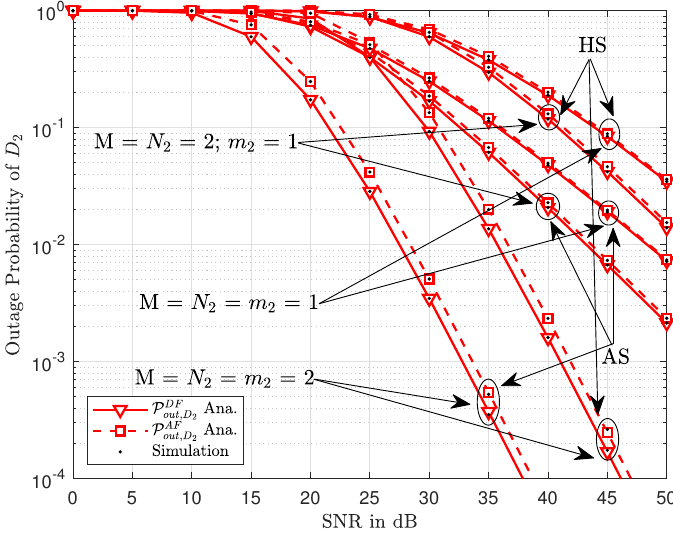
Figure 5. The outage probability of D 2 versus transmit